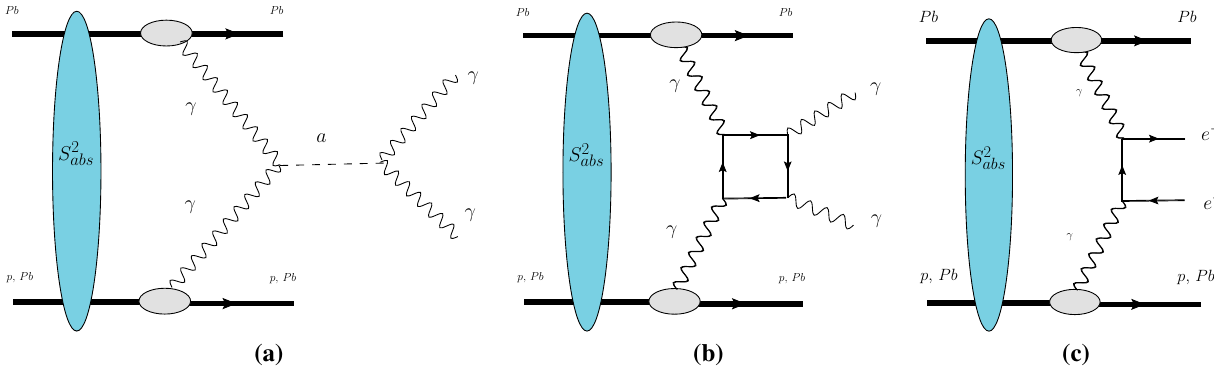
Fig. 1 Diphoton production in Pb – p / Pb – Pb collisions by a the γγ → a → γγ subprocess and b light-by-light scattering. The dielectron production, which is a important background when the electrons are misidentified as photons, is represented in the diagram c